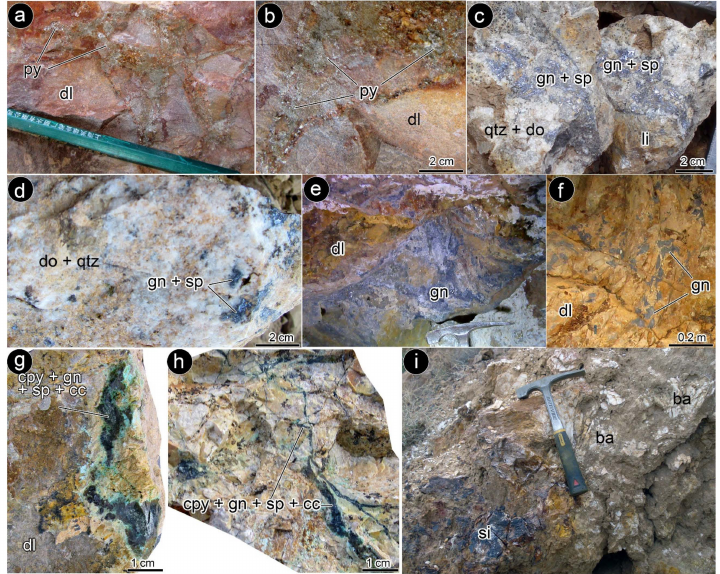
Figure 9. Hand specimen ( a – e , g , h ) and outcrop ( f , i ) photographs of sulfide and barite mineraliza- tion, Ab-Bid deposit. ( a , b ) Sparry dolomite, and pyrite (py) filling fractures within crackle breccia. ( c – f ) Replacement of hydrothermal dolomite (do), quartz (qtz), sphalerite (sp), and galena (gn) in dolomitic limestone (dl). ( g , h ) Chalcopyrite (cpy), galena, sphalerite, and chalcocite (cc) filling frac- tures within crackle breccia of dolomitized limestone (dl). ( i ) Massive barite (ba) mineralization in silicified (si)